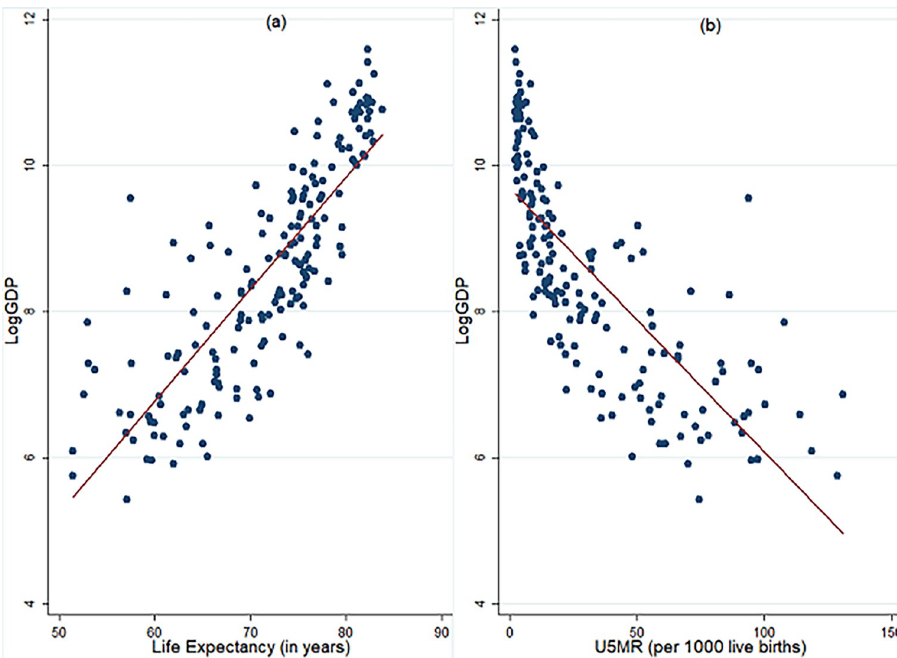
Fig 1. Relation between income per capita and indicators of population health. a) LogGDP vs Life Expectancy b) LogGDP vs U5MR. The data pertains to 193 countries for 2015 and is procured from World Development Indicators (WDI) database of World Bank. LE: Life Expectancy at birth (in years). U5MR: Under-five mortality rate is the probability per 1,000 that a new-born child will die before reaching age five, if subject to age-specific mortality rates of the specified year. LogGDP: Natural Logarithm of real GDP per capita at constant 2010 USD.